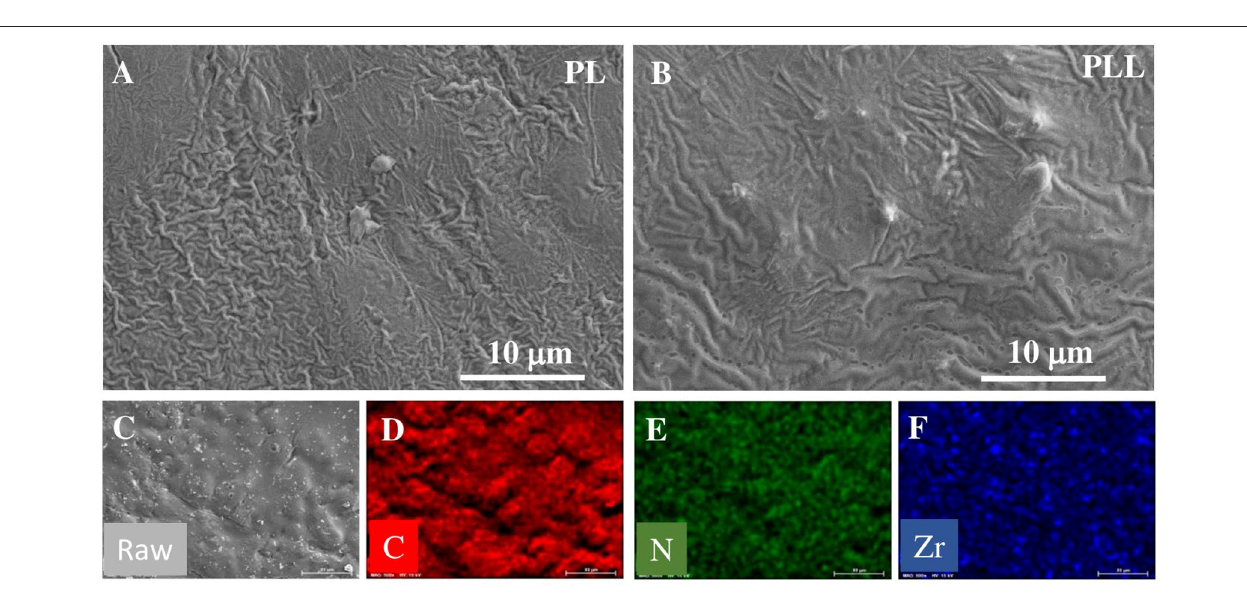
Frontiers in Chemistry |